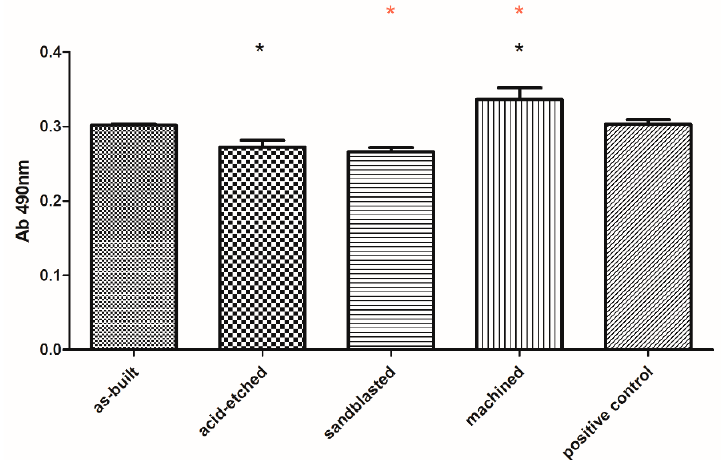
Figure 10. Survival of fibroblasts in media, in which surface-modified samples were immersed, compared to untreated fibroblasts (positive control box) (average values and standard deviation). Asterisks mark statistically significant differences between specific types of samples (K-W test, p < 0.001).